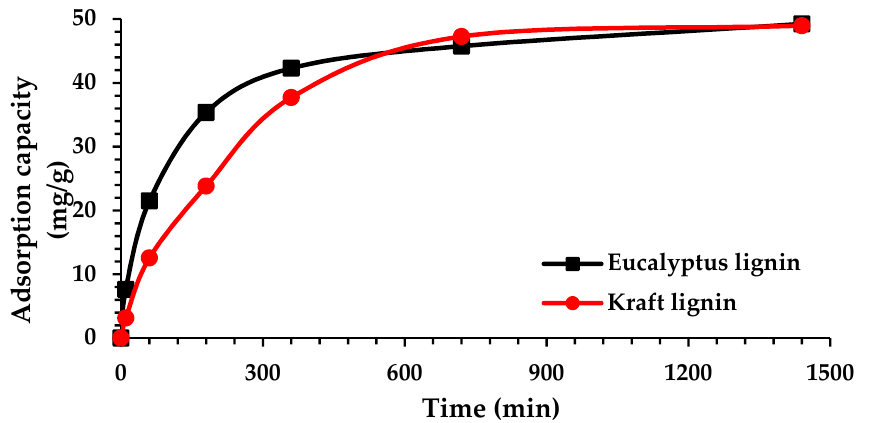
Figure 6. Effect of time on adsorption capacity of lignin for Cr(VI) ions (C 0 = 50 mg/L, m = 0.1 g, V = 100 mL).